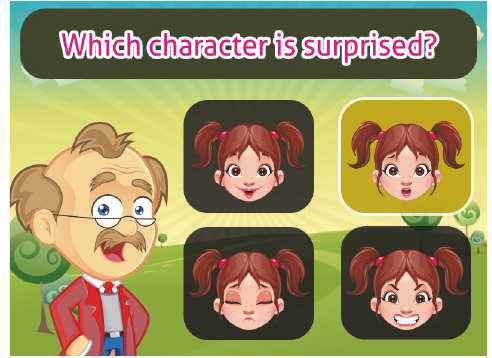
Figure 14: Teaching facial expressions, surprise.